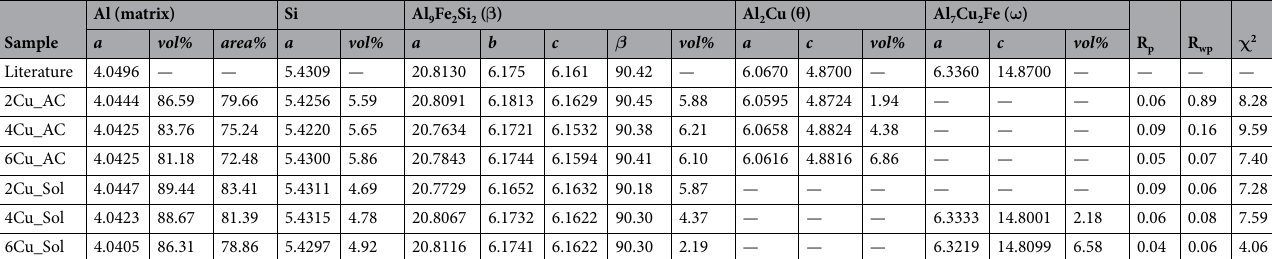
ω -Al 7 Cu 2 Fe phase (brighter contrast)